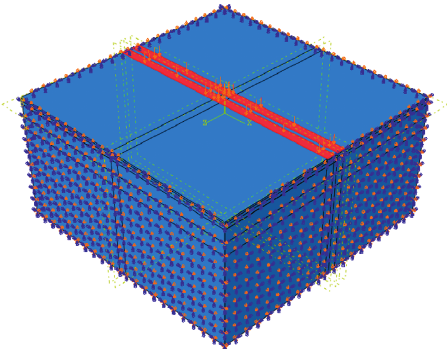
Figure 6: Schematic of traffic load action